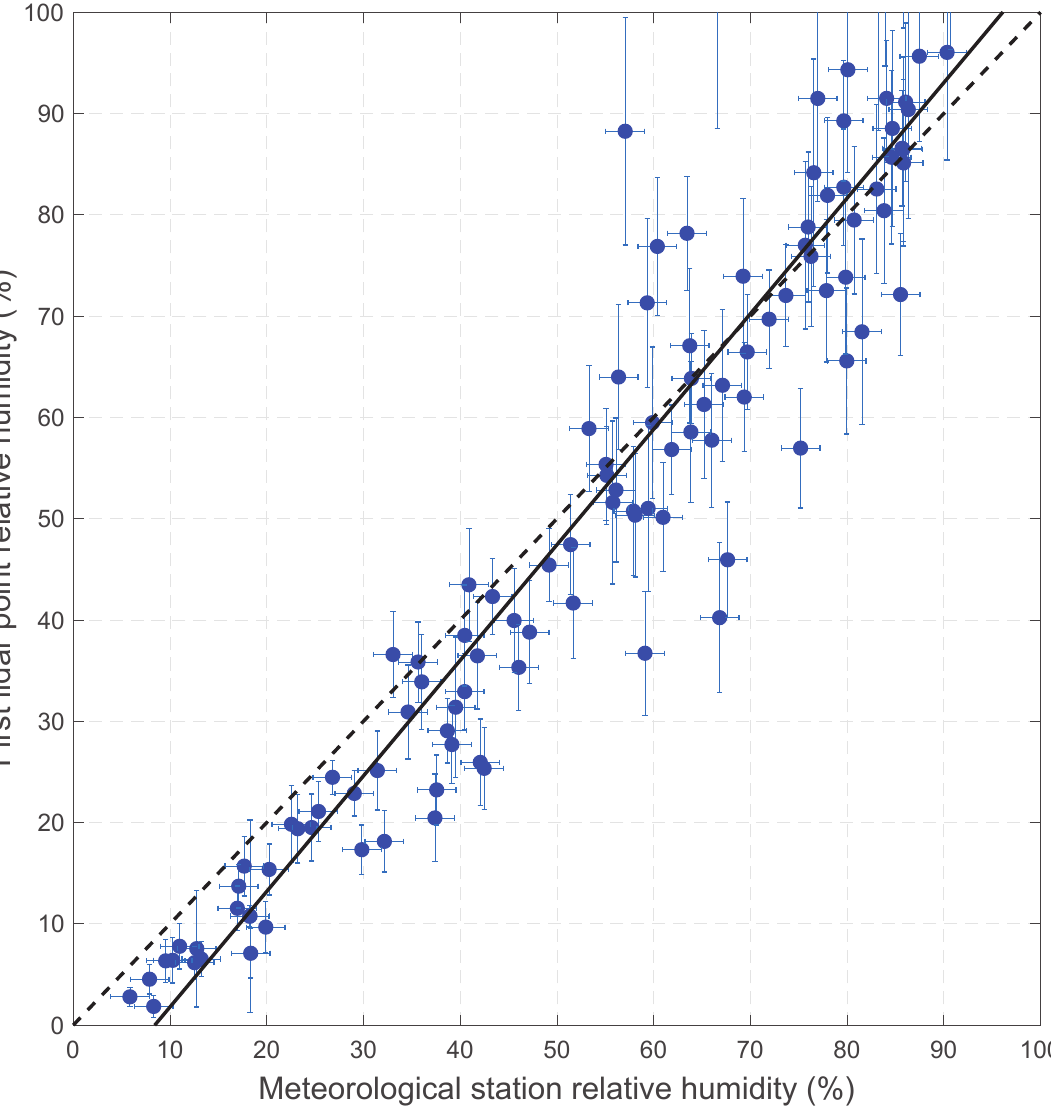
Figure 1. Dispersion of the relative humidity (%) between the first vertical point of the Lidar1200 and the Fourier transform infrared (FTIR) meteorological station (Maïdo Observatory) between November 2013 and October 2015. The black dotted line shows the 1:1 relationship and the black dashed line shows the best linear fit to the data. The uncertainty of each instrument is indicated with a blue line, vertical for the total uncertainty of the lidar and horizontal for the 2% uncertainty of the meteorological